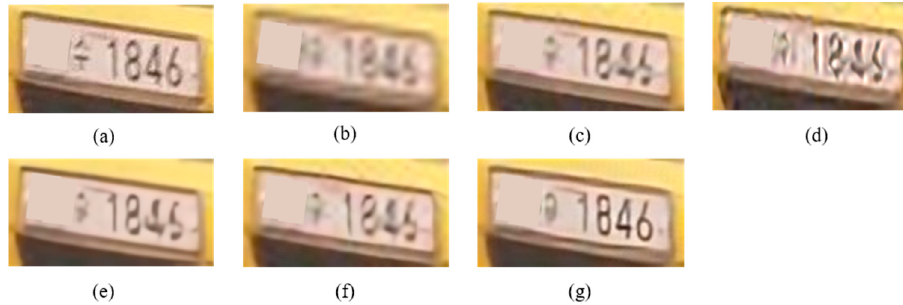
Figure 6. SR results of the first plate image (4 × ). ( a ) HR (128 × 64), ( b ) Bicubic, ( c ) DRN, ( d ) MZSR, ( e ) USRNet, ( f ) DBPN, ( g ) Proposed. Two characters were masked due to privacy policies.